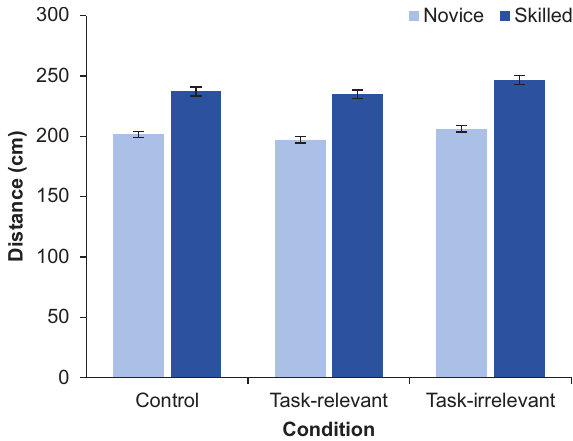
Figure 1. Standing long jump outcome measures (mean) with different attentional cues in novice and skilled par- ticipants. Error bars represent standard